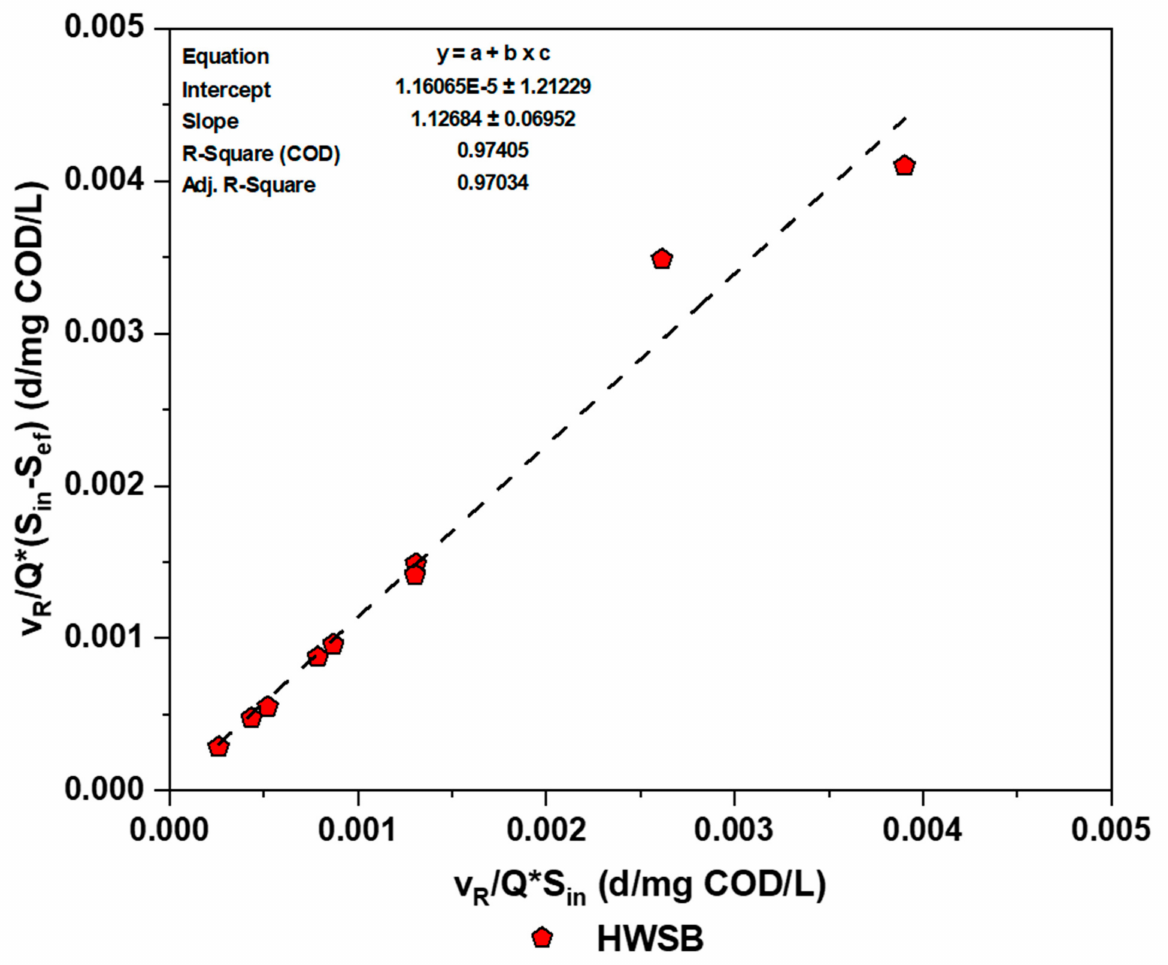
Figure 10. Modified Stover kinetic plot of COD for